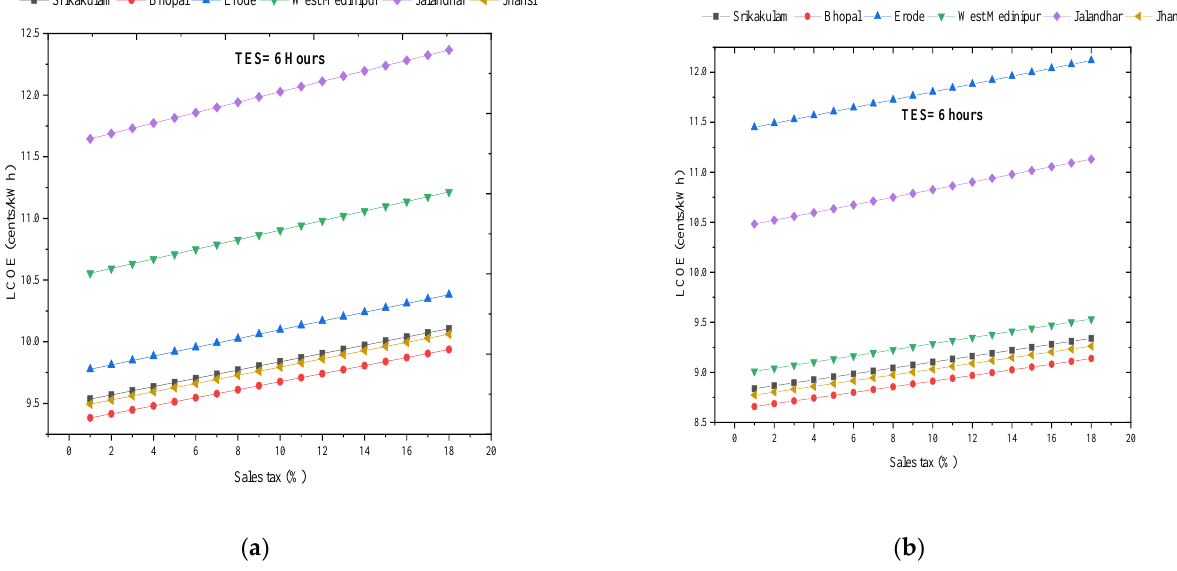
Figure 9. Effect of sales tax rate on the LCOE of both models, ( a ) dry-cooled and ( b ) wet-cooled, at 6 h TES for SM of